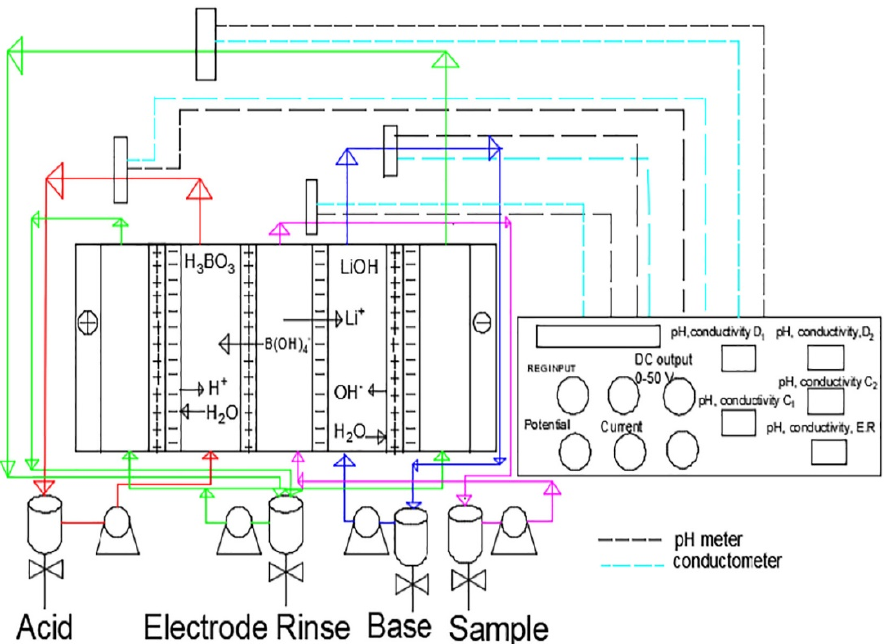
Figure 18. The flow scheme of a BMED system [111].